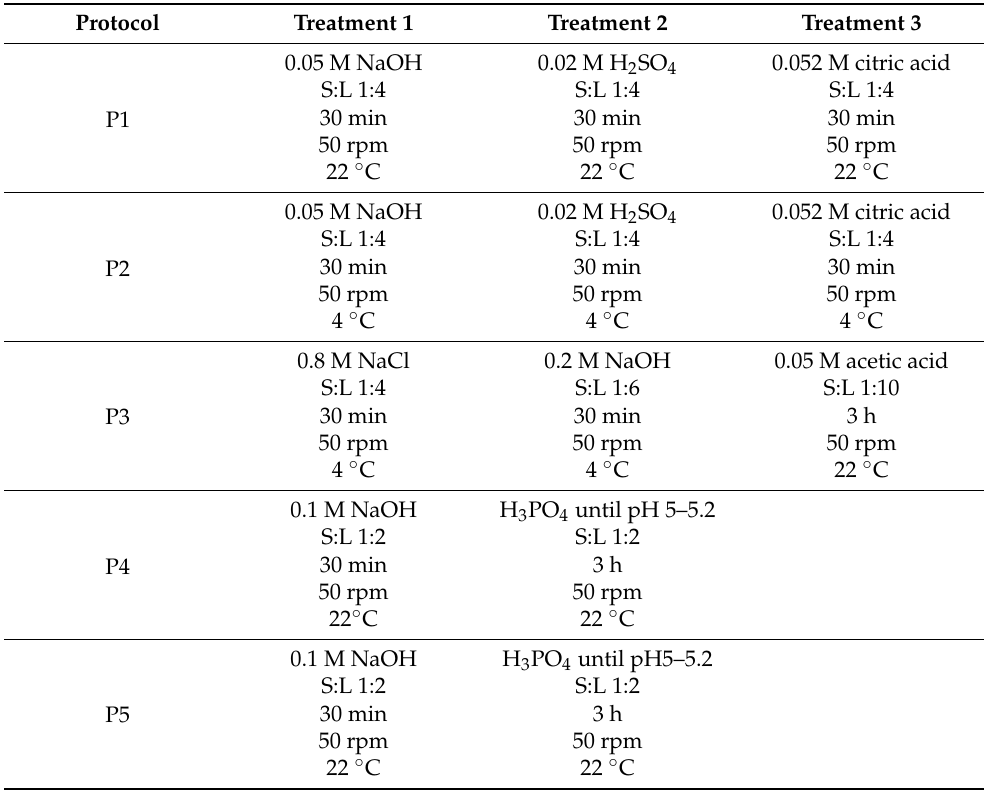
Table 1. Chemical treatments applied for gelatin extraction in each protocol. S:L solid to liquid